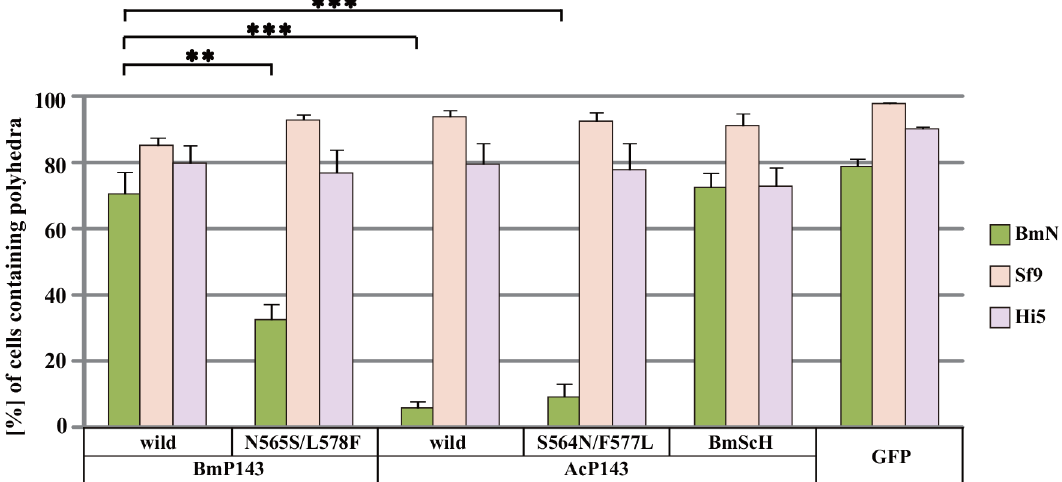
Fig 3. Effect of DmHSP70 promoter-driven P143 recombinant proteins on polyhedron formation. BmN, Sf9 and Hi5 cells were transfected with plasmids expressing the P143 recombinant proteins indicated. The transfected BmN cells were infected with wild-type BmNPV and the transfected Sf9 and Hi5 cells were infected with wild-type AcMNPV. At 72 hpi, the proportion of polyhedron-containing cells was calculated under a fluorescence microscope. Average of three experiments ± SEM are shown. Student's t -test: ( ** ) p < 0.01; ( *** ) p < 0.001. ANOVA: BmN p = 4.2 x 10 − 8 ; Sf9 p = 0.0453; Hi5 p =